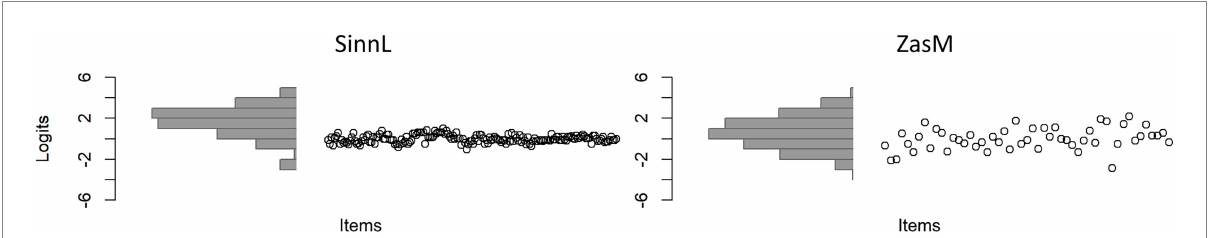
FIGURE 1 Wright map (Lunz, 2010) of the item pools ( x axis stating the progress of items, test run with each dot being one item, and y axis stating the item difficulty. The histogram displays the person parameters).